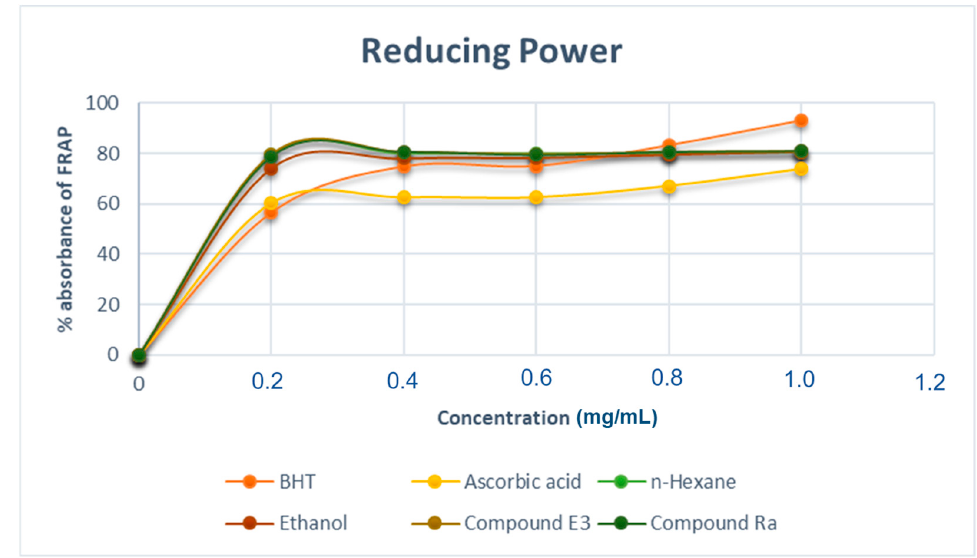
Figure 10. % Reducing power of M. oleifera extracts and pure compounds. The results are presented as the percentage reducing power free radical scavenging activity. Each value is expressed as mean ± standard deviation ( n = 3).